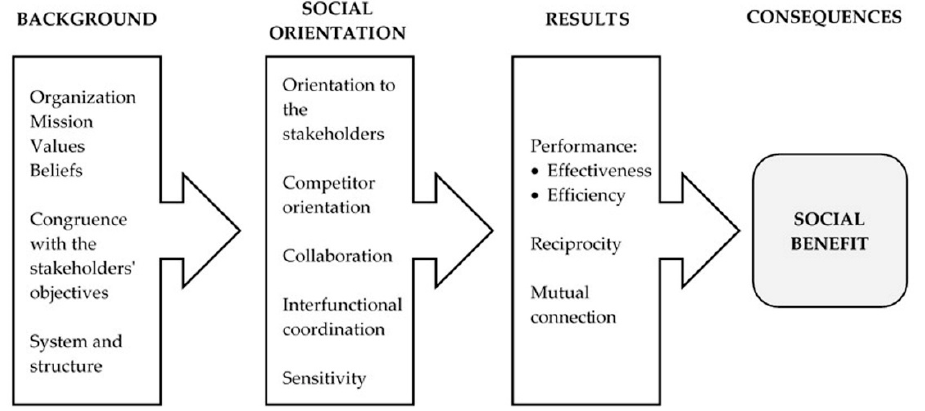
Figure 2. Social orientation model. Source: Sargeant et al. (2002).